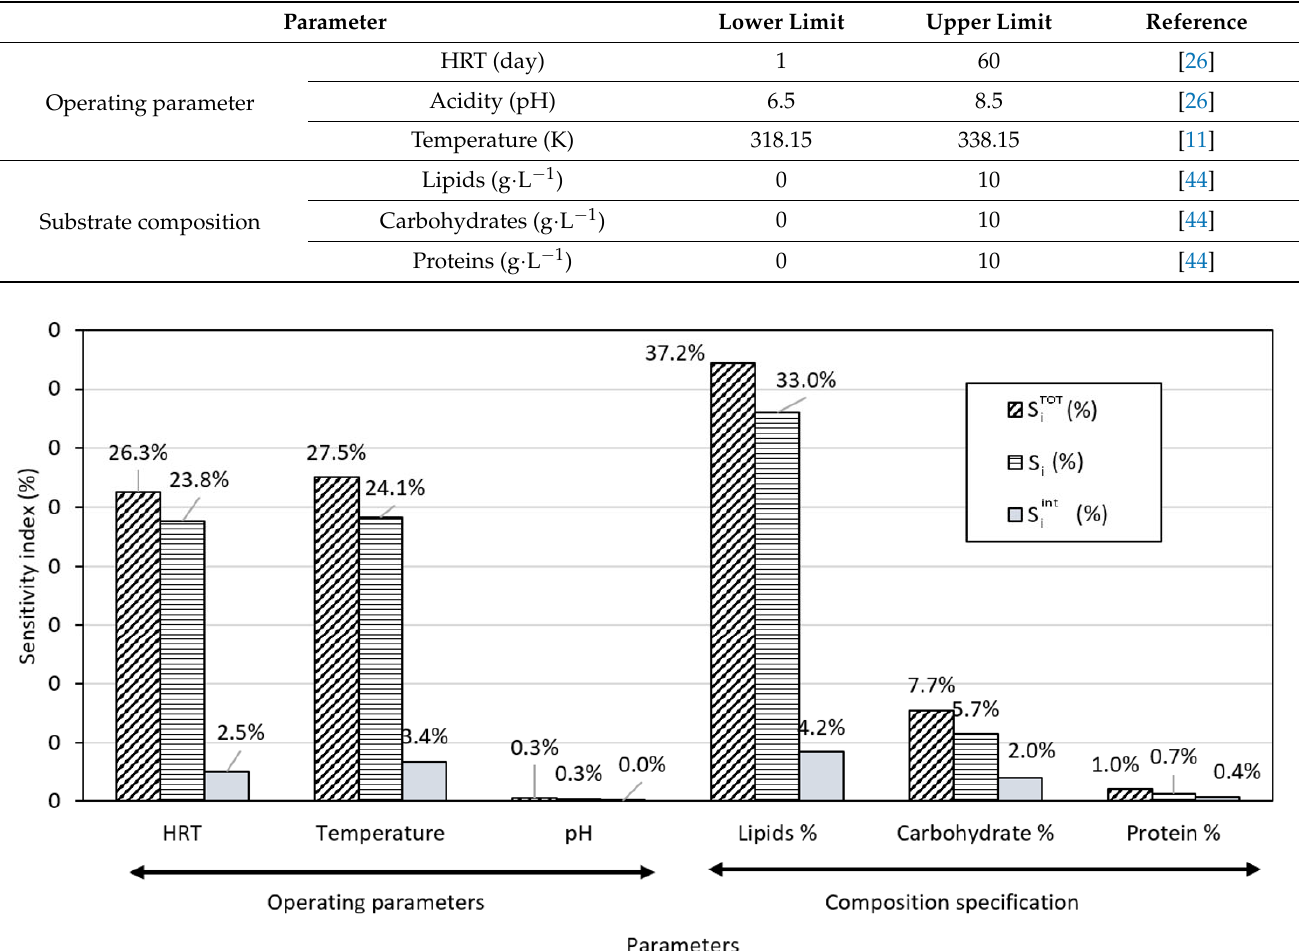
Figure 2. ( S iTOT ) Total sensitivity index, ( S i ) first-order sensitivity index, and ( S iint ) interaction sensitivity index for each evaluated parameter.